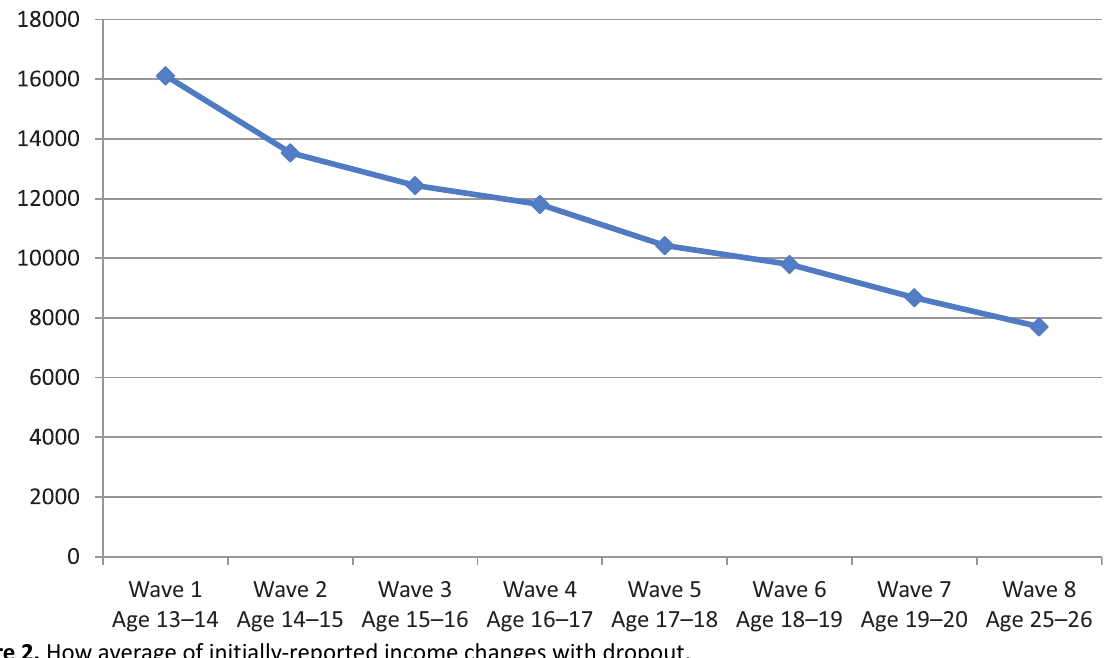
Figure 2. How average of initially-reported income changes with